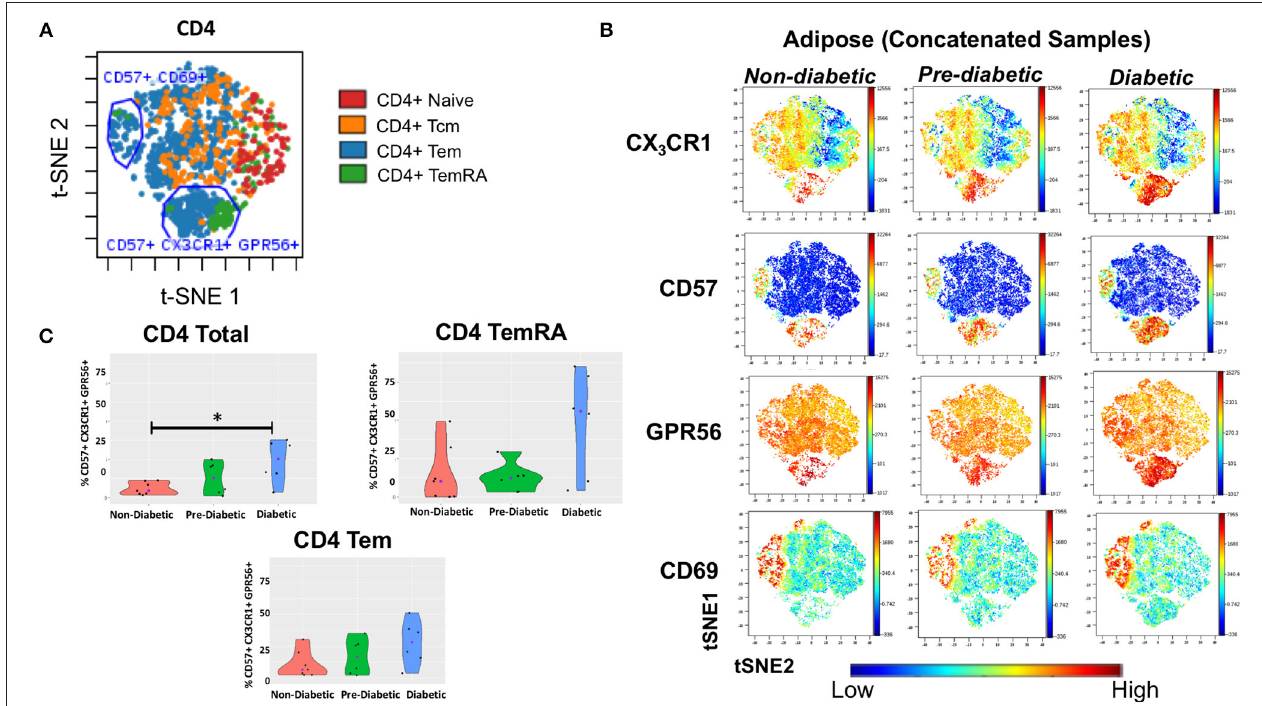
FIGURE 5 | CD4 + T cells co-expressing CD57, CX 3 CR1, GPR56 in subcutaneous adipose tissue increase with progressive glucose intolerance. viSNE plots were generated in cytobank to identify groups of cells that differ between non-diabetic, pre-diabetic and diabetic categories. (A) Clusters of CD4 + , T Nai , T EM , T CM , and T EMRA cells from subcutaneous adipose tissue (SAT). (B) Concatenated viSNE plots of non-diabetic, pre-diabetic, and diabetic PLWH showing clusters of cells expressing CX 3 CR1, CD57, GPR56, and CD69. (C) Violin plots showing percentage of total CD4 + , T EM , and T EMRA cells co-expressing CD57, CX 3 CR1, and GPR56. Mann-Whitney test used to analyze differences between metabolic groups; * P <